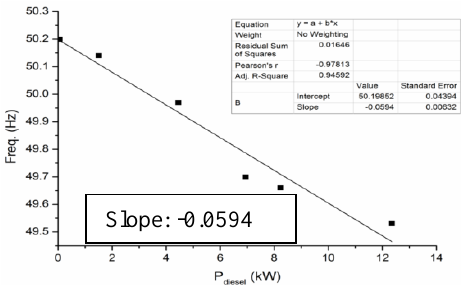
Figure 8. The measured f-P droop curve of the diesel genset for 3-phase symmetric loading.